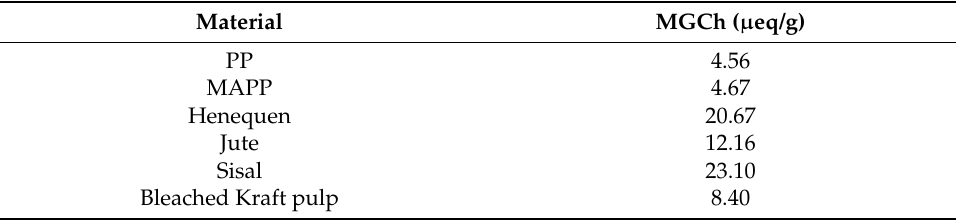
Table 2. Surface charge density of PP, MAPP, Henequen fibers, and other typologies of fibers.